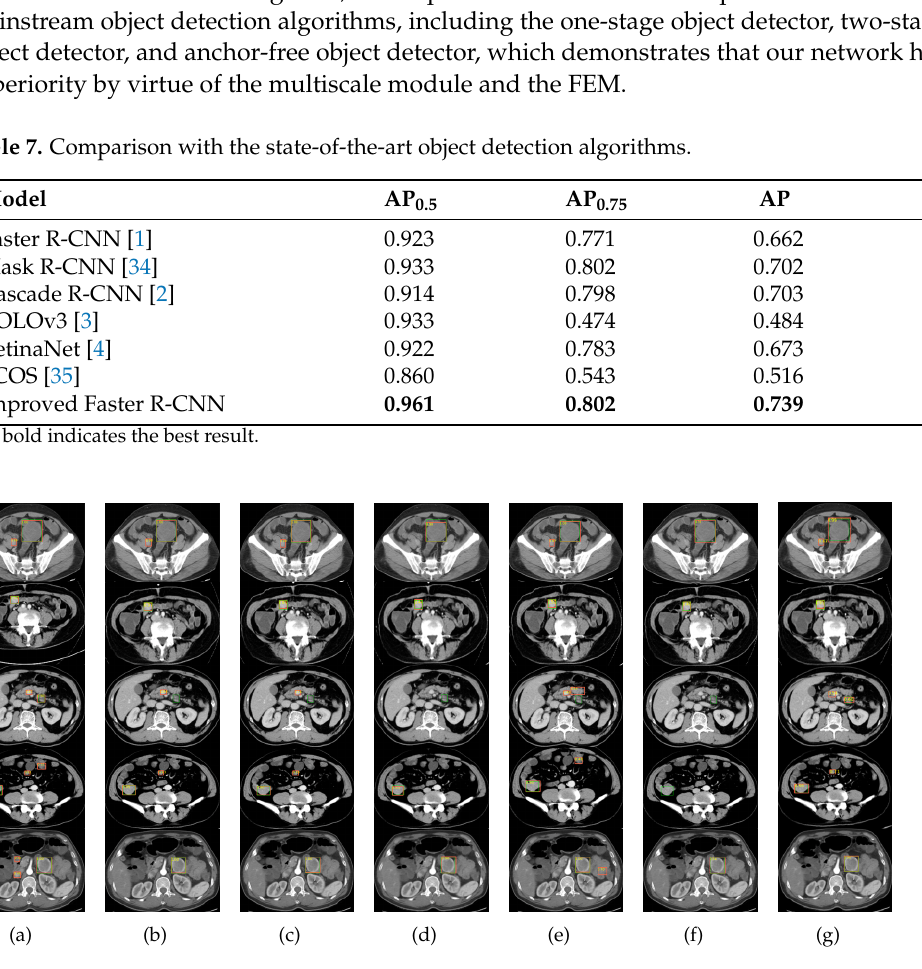
Figure 6. Visual comparison of the different object detection algorithms including ( a ) Faster R-CNN, ( b ) Mask R-CNN, ( c ) Cascade R-CNN, ( d ) YOLOv3, ( e ) RetinaNet, ( f ) FCOS, and ( g ) Improved Faster R-CNN. The orange bounding box in the figure represents the predicted box, and the green bounding box represents the actual labeled